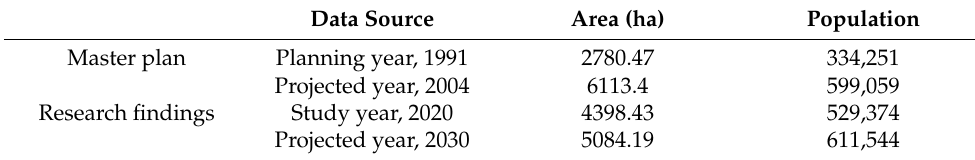
Table 7. Area and population of the of the Ardabil city in the Master Plan and this research results for 2020 and